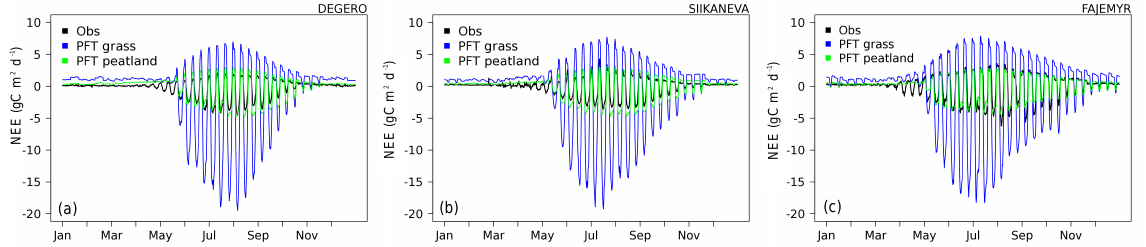
Figure 4. Diurnal cycle of NEE smoothed with a 10-day running-mean filter of modelled PFT peatland (green), modelled PFT grass (blue) and observation (black) from the peatland sites of Degero (a) , Siikaneva (b) and Fajemyr (c) .